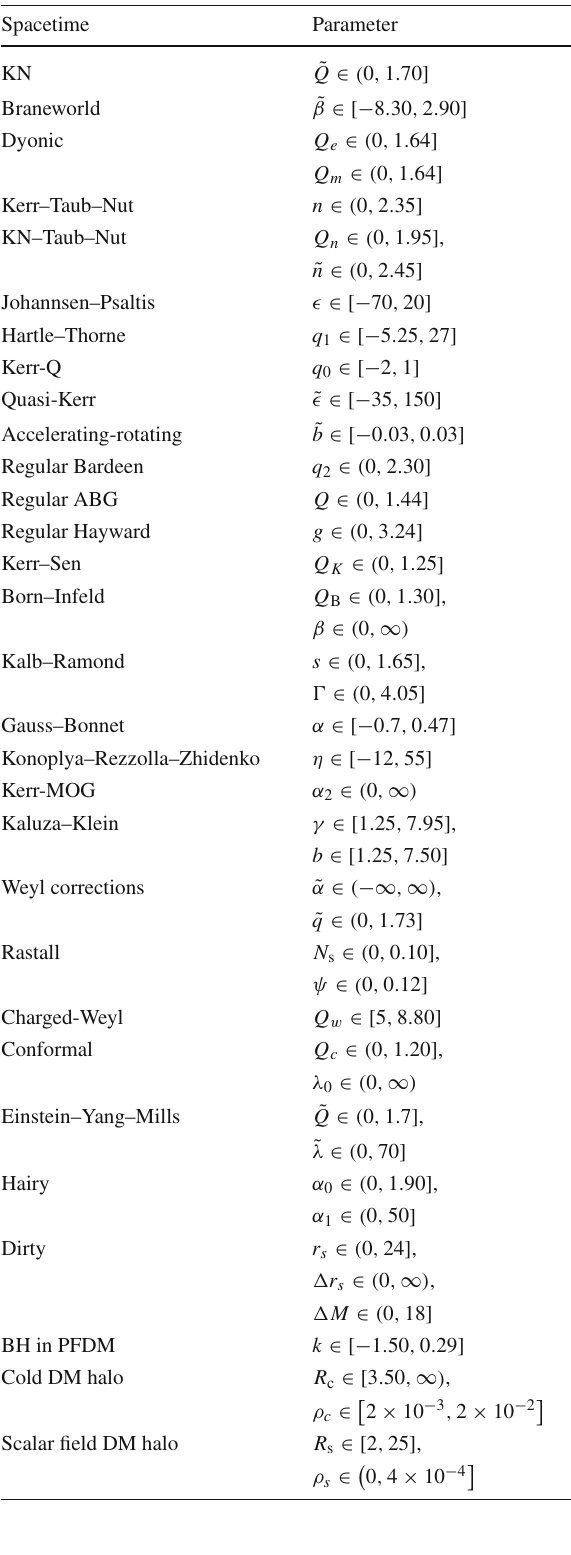
Table 1 The bounds on the parameters for various axisymmetric spacetimes, estimated from the observational data of three flares,